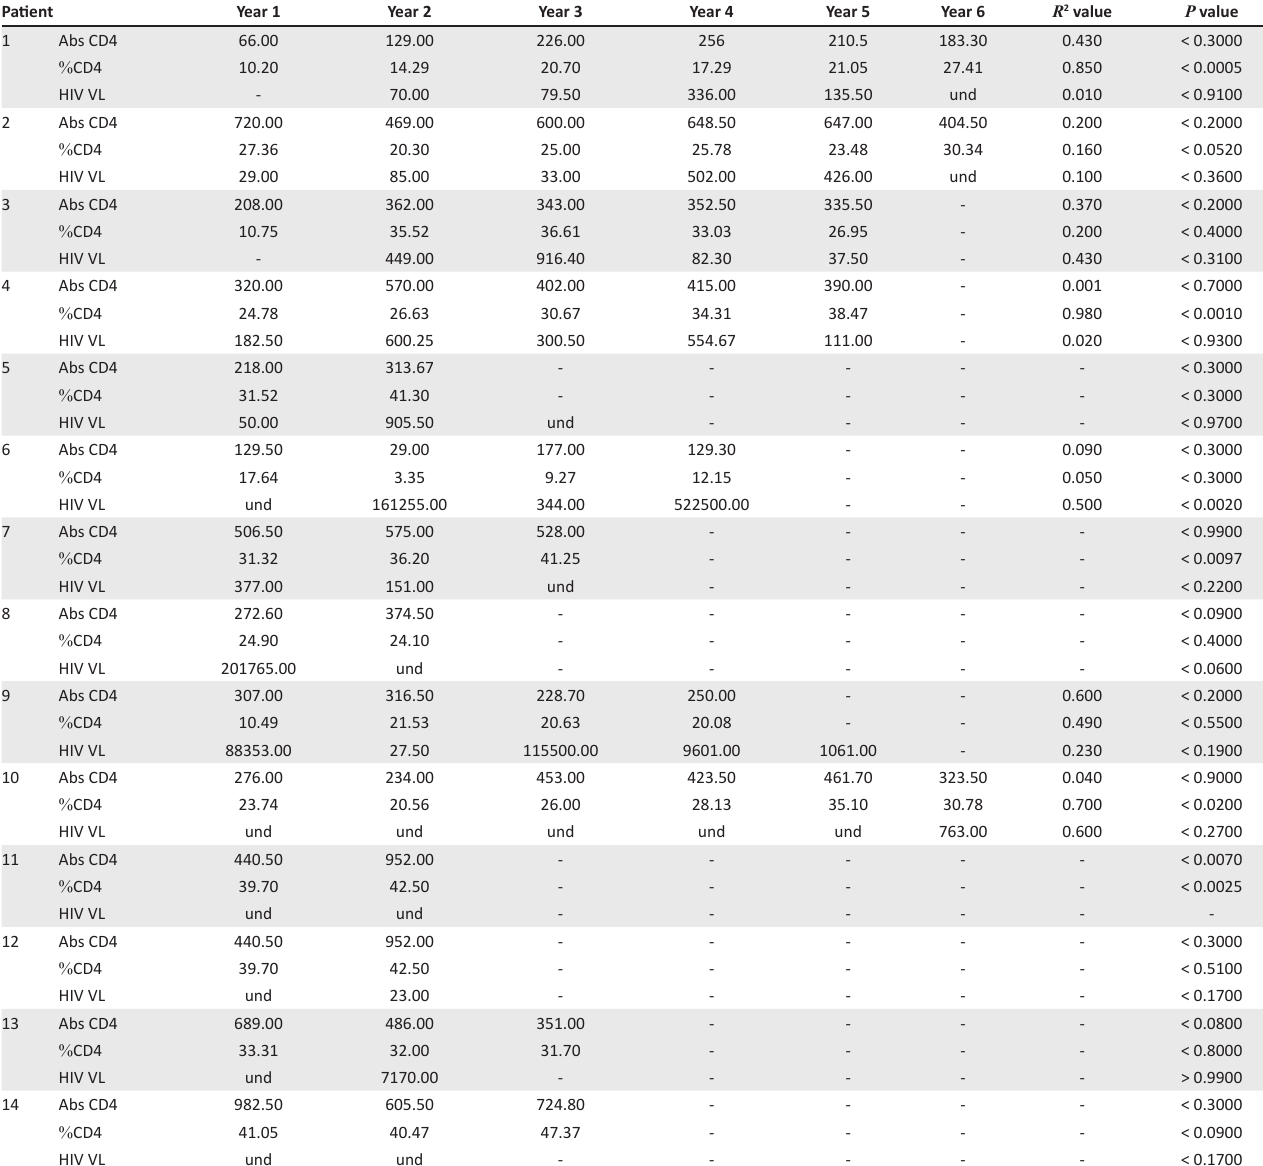
TABLE 1-A1: Time series analysis of the longitudinal absolute CD4+ T cell count, % CD4+ T cells and HIV viral loads (VL).